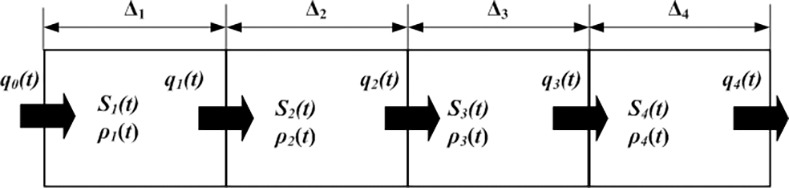
Street A of the test intersection.